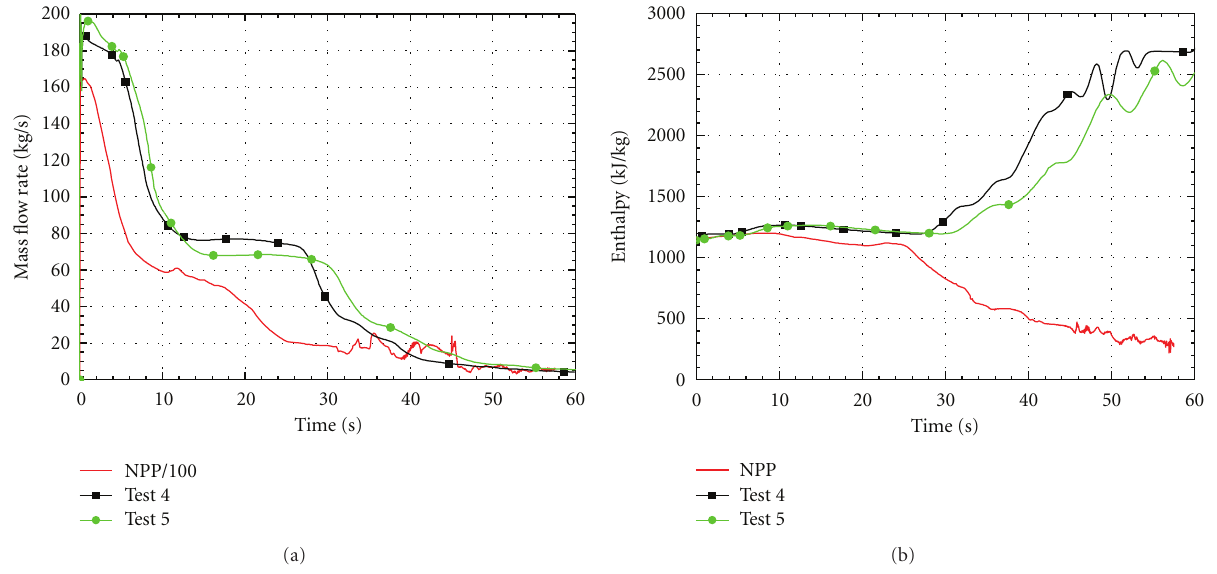
Figure 9: Comparison of experimental MERs with NPP scaled MER. Tests 4 and 5. (a) Break mass flow rate, (b) break